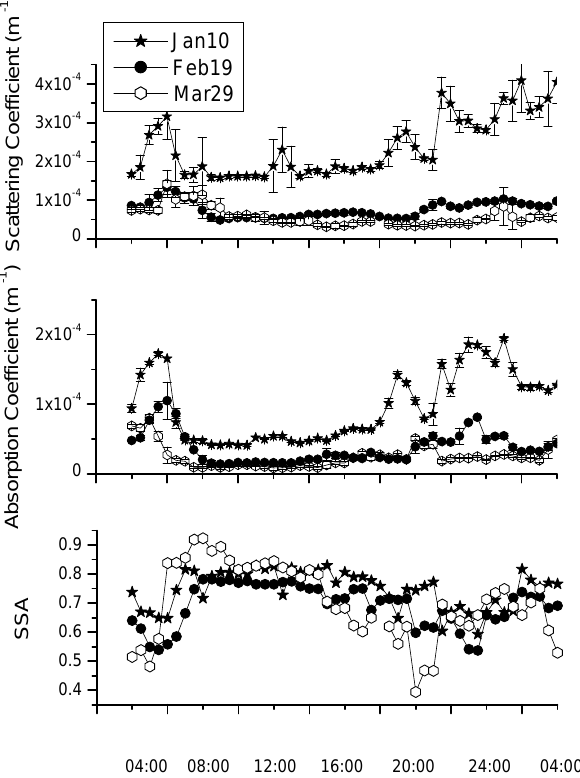
Time (IST) Fig. 9. Diurnal variation of scattering coefficients (top panel) and absorption coefficients (middle panel) and SSA (bottom panel) at 550nm for typical winter days (10 January and 19 February 2007) and one typical summer day (29 March 2007).